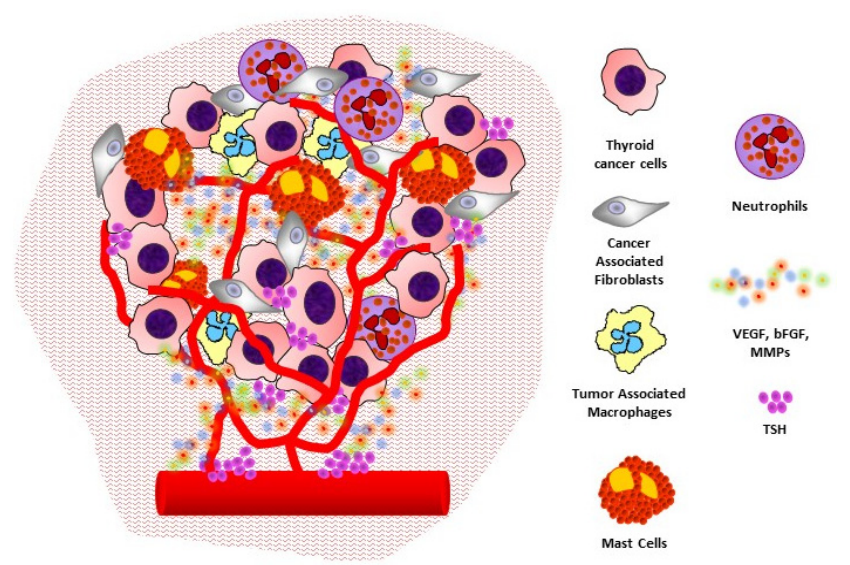
Figure 1. The angiogenic microenvironment of thyroid cancer: interactions between cancer cells, stromal cells, and inflammatory cells to promote angiogenesis and tumor progression.